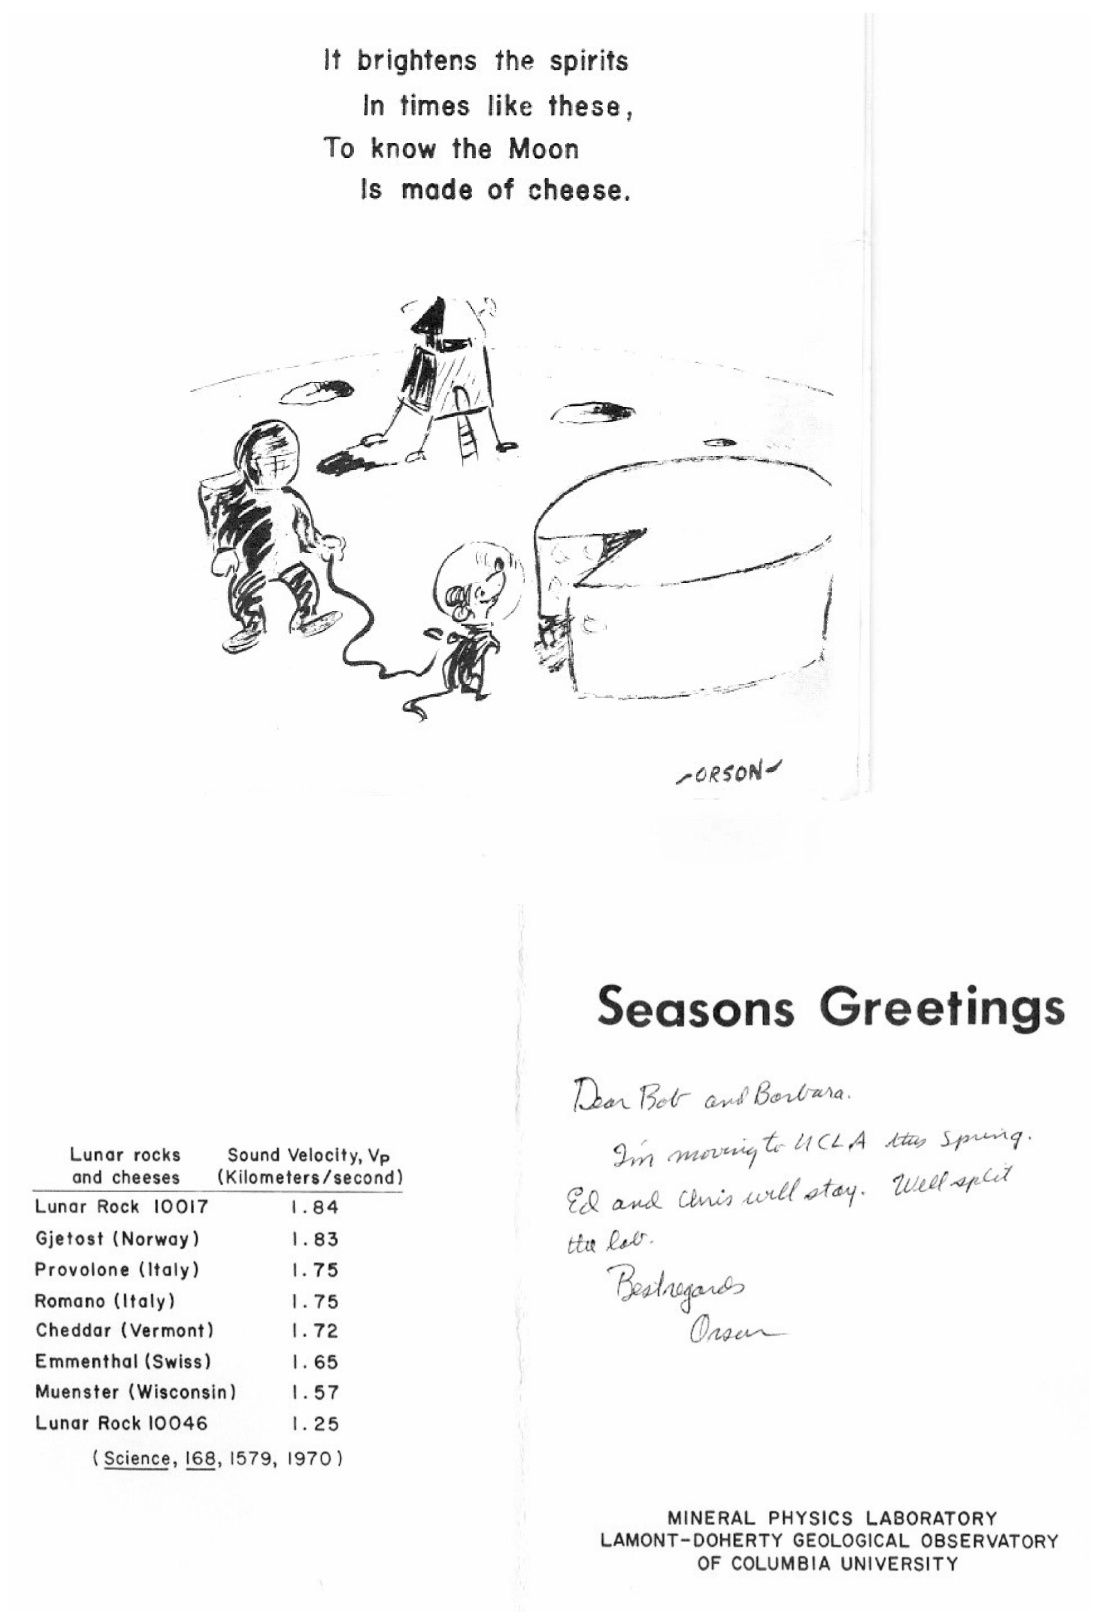
Figure 6. From Christmas card sent by Schreiber and Anderson to colleagues in 1970. Based on Schreiber and Anderson [26] showing velocities of lunar rocks compared with terrestrial